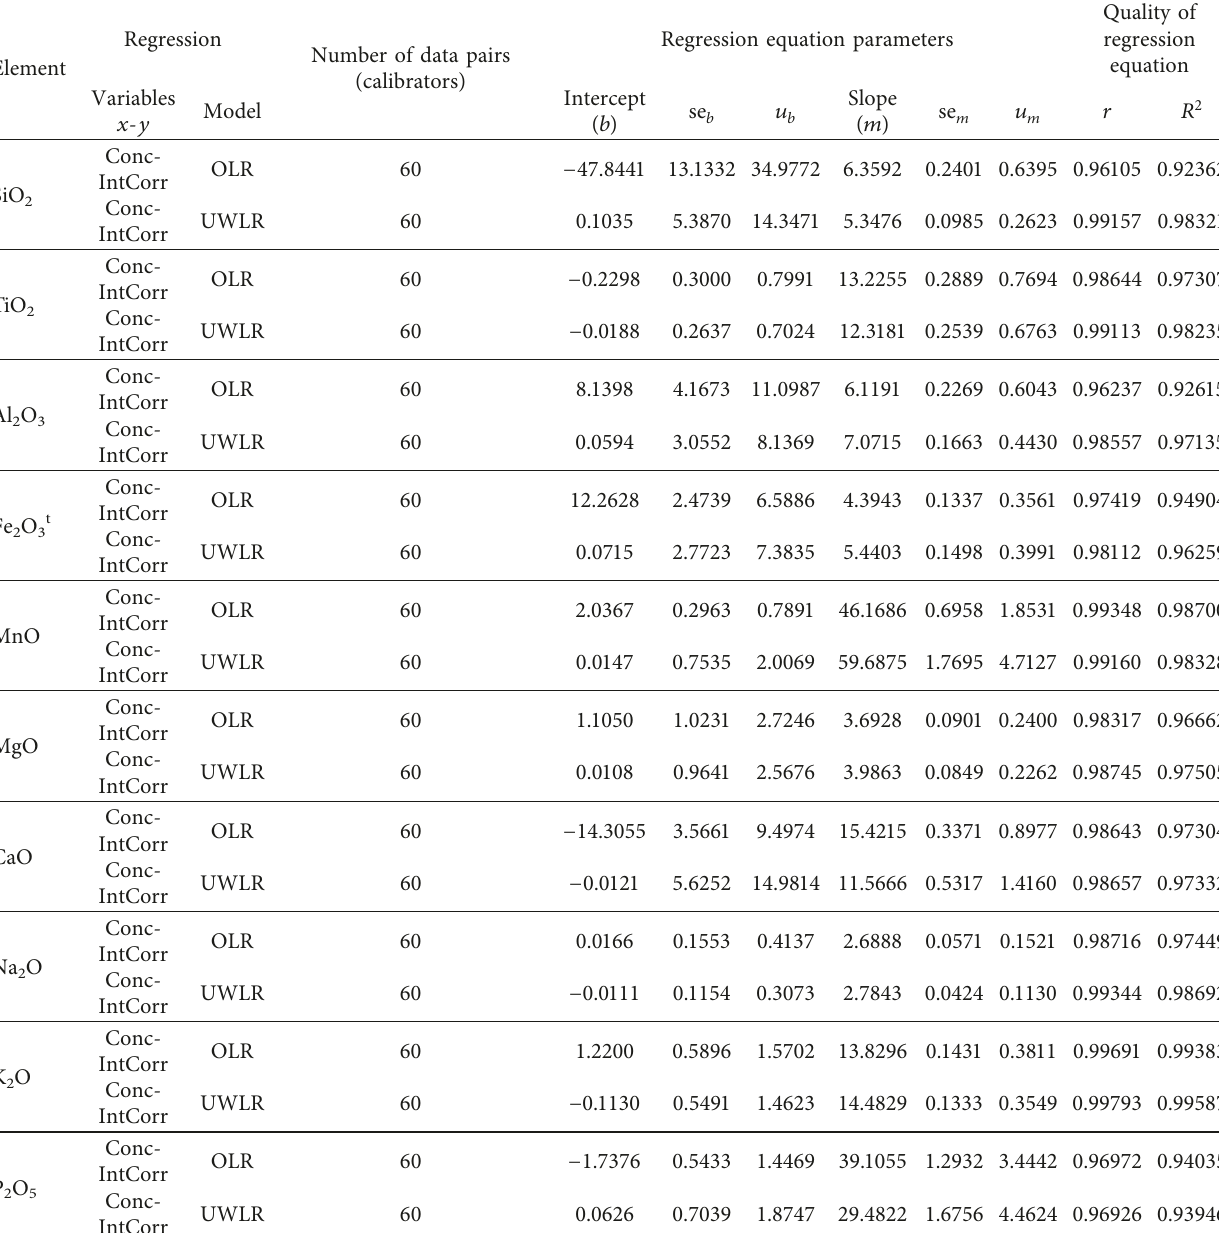
Table 1: Instrumental sensitivities ( x - y : concentration-matrix-corrected intensity (Conc-IntCorr) regression model; mean and 99% uncertainty) for major